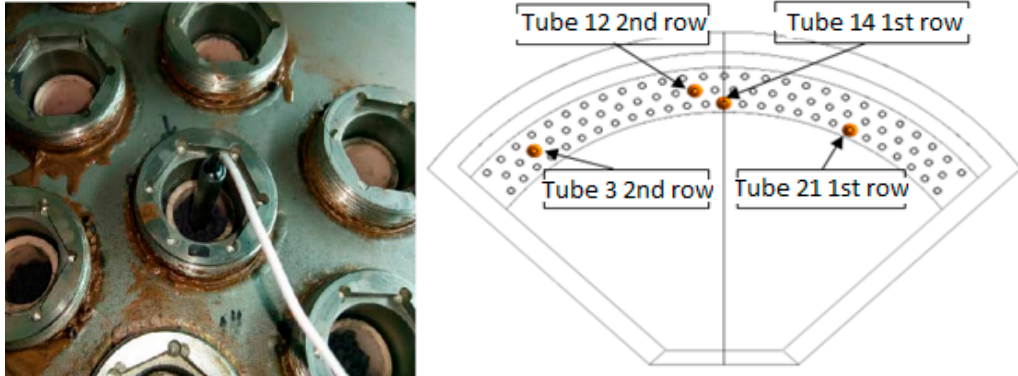
Figure 5. (left) Detailed view of the tubes filled with ferrites and with a thermocouple installed. (right) Distribution of the four thermocouples arranged inside the tubes.